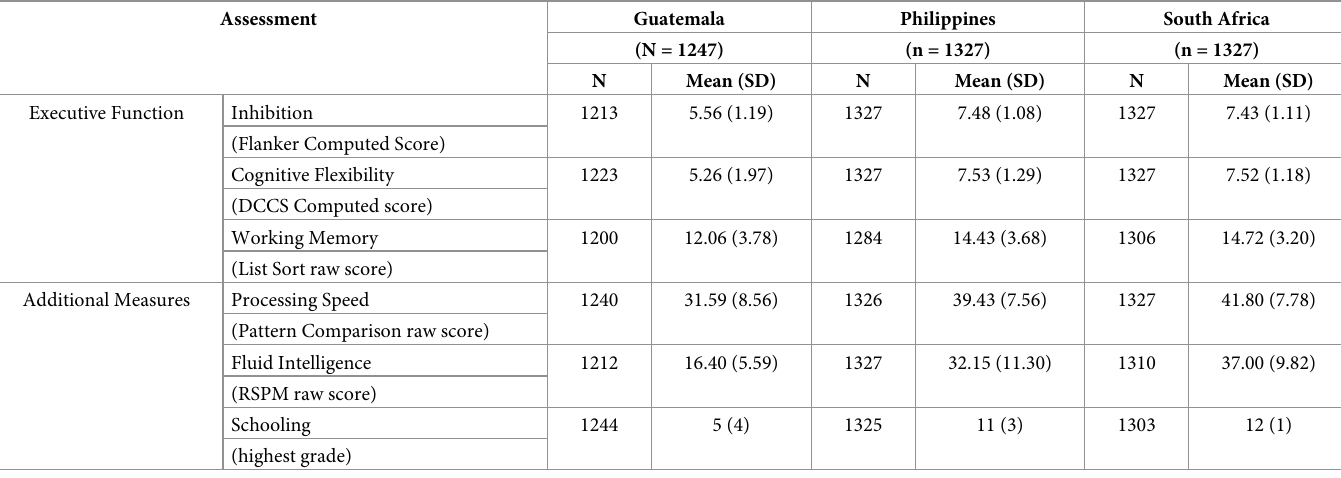
Table 1. Means scores (SD) for each measure, in each cohort.